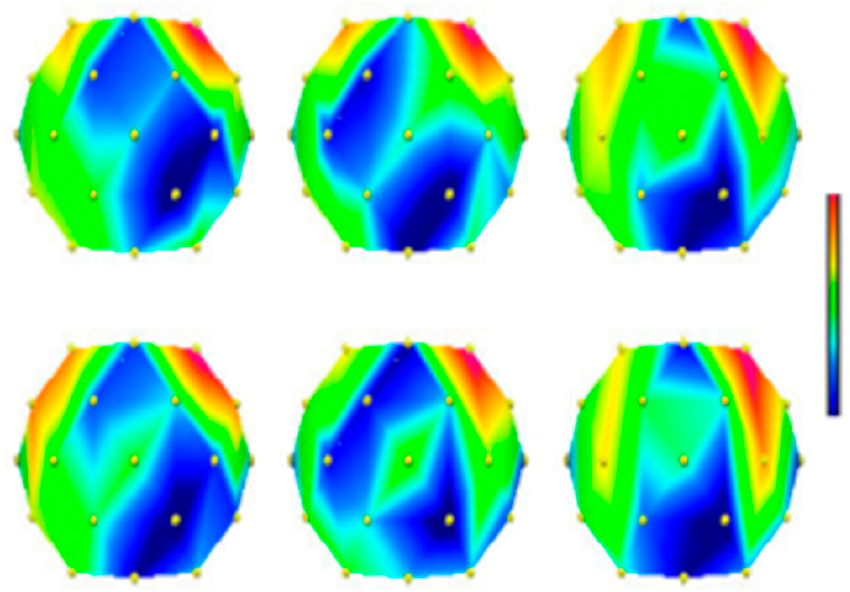
Figure 2. Power maps of subject 2 for two consecutive recordings [17] for all three considered tasks. In addition, the allotted band was 8–12 hertz, where electrode’s positions are represented by filled circles.